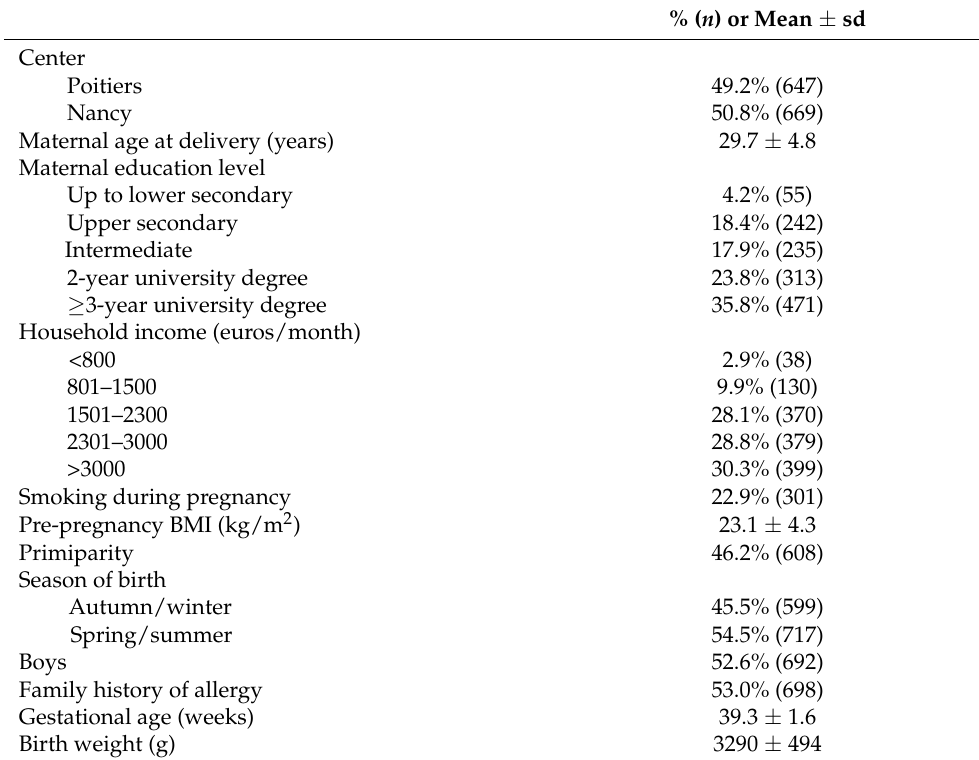
Table 1. Characteristics of the study population ( n = 1316).